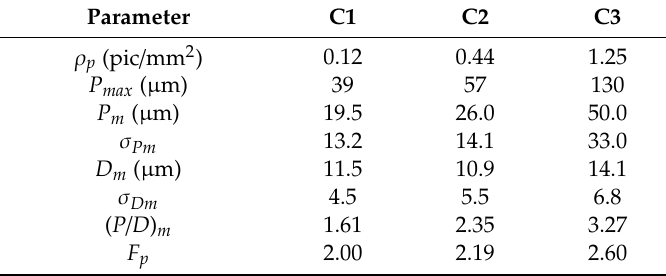
Table 1. Parameters determined by confocal microscopy for a total area ( A imla_conf ) of 33 mm 2 where ρ p is pit density, P max is the deepest pit value detected, P m is the average pit depth, σ Pm is the standard deviation of P m , D m is the average pit diameter measured at surface, σ Dm is the standard deviation of D m , and F p is the pitting factor.